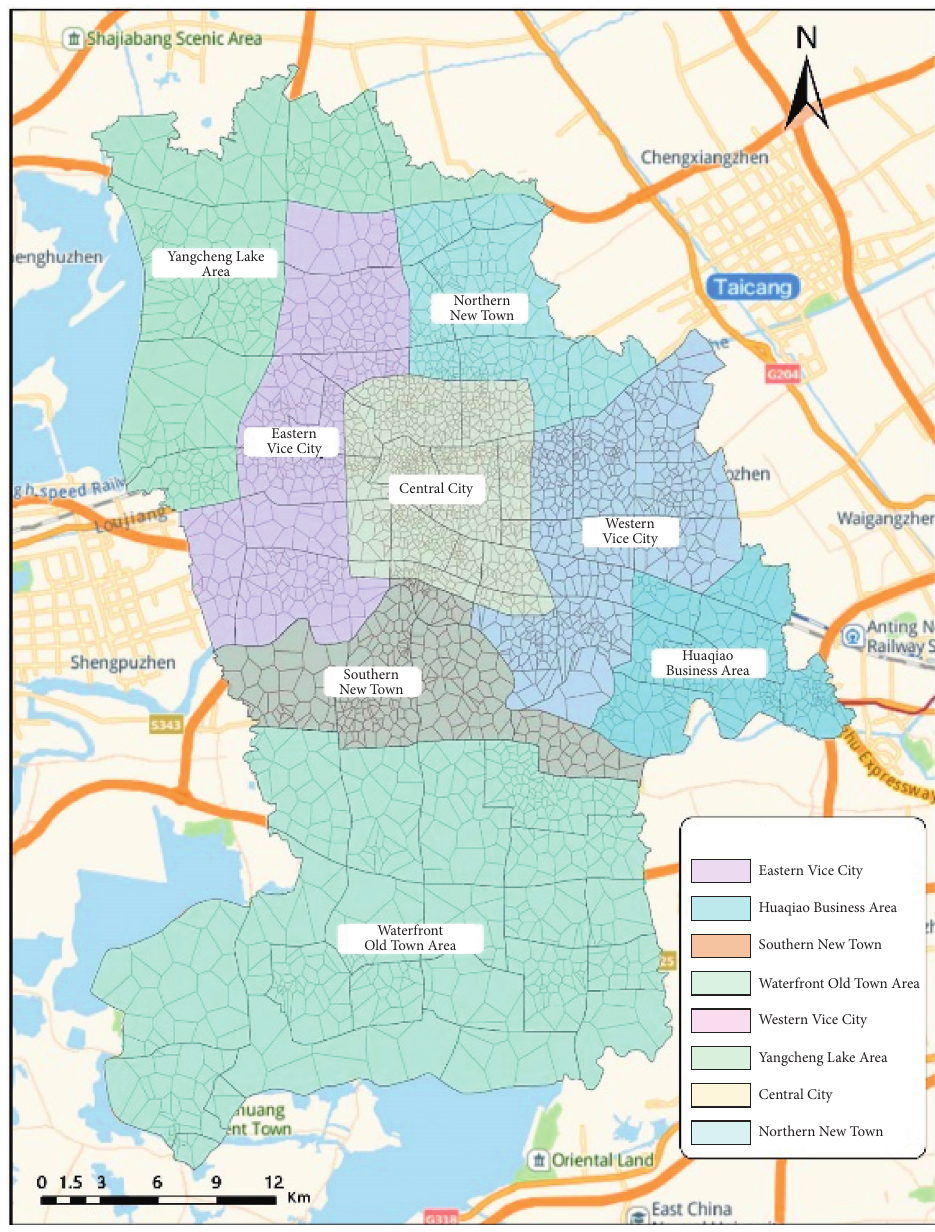
Figure 1: Division of the Kunshan study unit. Table 3: A sample record from mobile phone